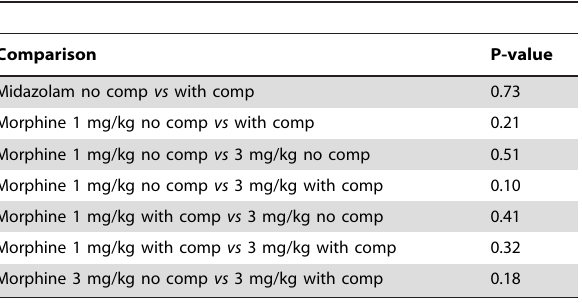
Table 1. Statistical analysis between experimental groups of LCEP AUC baselines before drug.